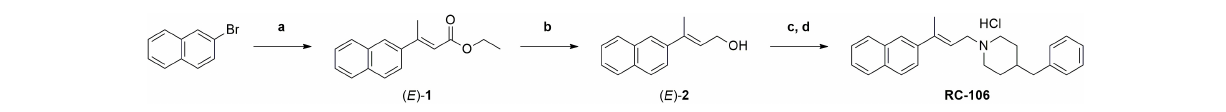
TABLE 1 | Pancreatic ductal adenocarcinoma cell lines characterization.